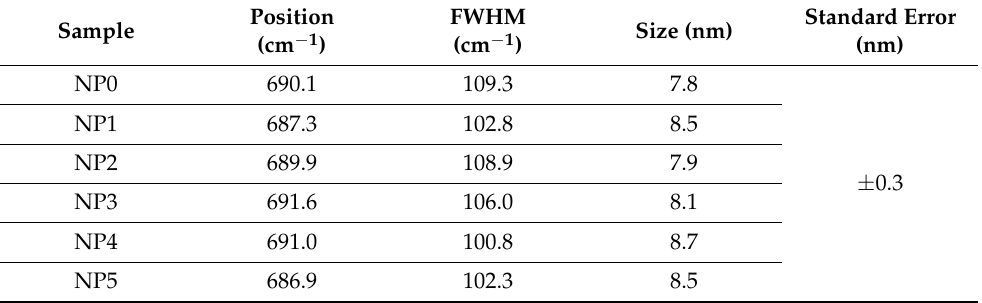
Table 2. Particle size statistics from peak 685 cm − 1 . The sizes were calculated using Equation